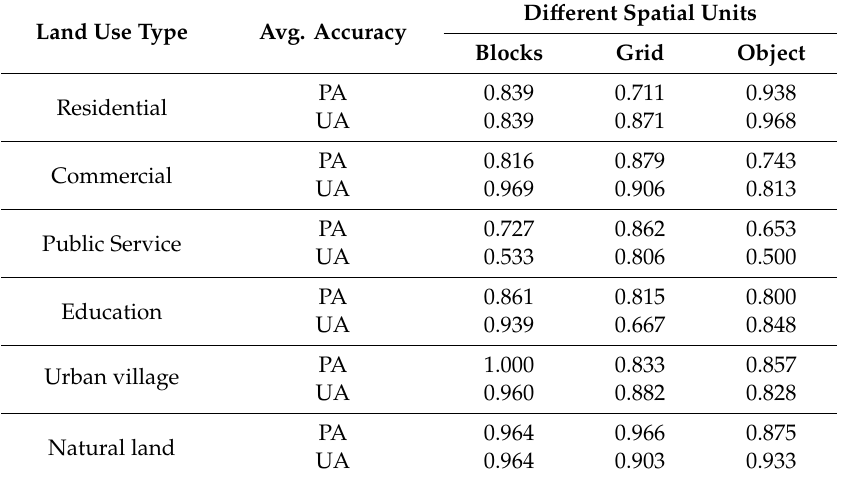
Table 3. Produce’s accuracy (PA) and user’s accuracy (UA) of urban functional classification using di ff erent